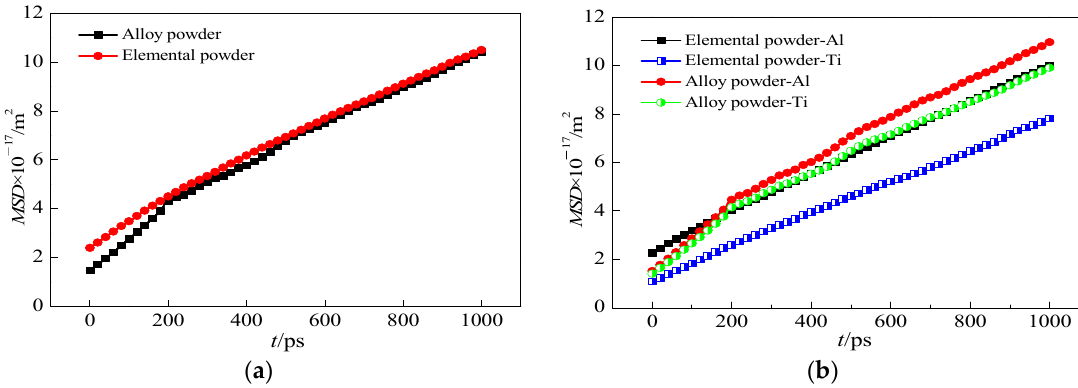
Figure 9. MSD of the alloy powder and elemental powder and their different elements in the Ti-Al alloy: ( a ) MSD of the alloy powder and elemental mixed powder system, ( b ) MSD of the elements in the alloy powder and elemental mixed powder.